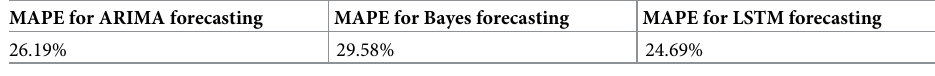
Table 6. Comparison of ARIMA with other forecasting